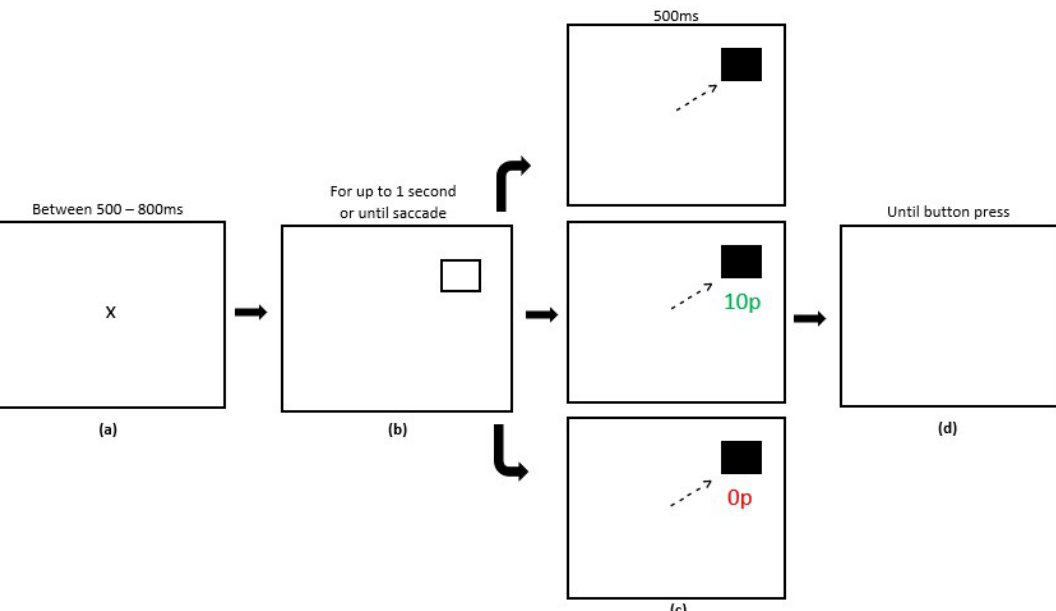
Figure 2. Sequence of events in the reward paradigm (adapted from Dunne et al., 2015 [31]; not to scale). ( a ) Participants were presented with a fixation cross for a variable time (500–800 ms). ( b ) The saccade goal was indicated by the appearance of a hollow square displayed for up to 1000 ms or until a saccade was made. ( c ) After a successful saccade or 1000 ms, participants received visual feedback in the colour change of the target stimulus. In the conditioning phase, when the target appeared at the rewarded location, successful saccades yielded a reward of 10 p on 60% of trials (Panel 2). No rewards were available when the target appeared at the unrewarded location, indicated by the presence of ‘0 p’. In the post-conditioning phase, no reward was available (Panel 3). Feedback was presented for 500 ms. ( d ) After a saccade towards the target, the trial ended and participants were required to press a button to start the next trial.